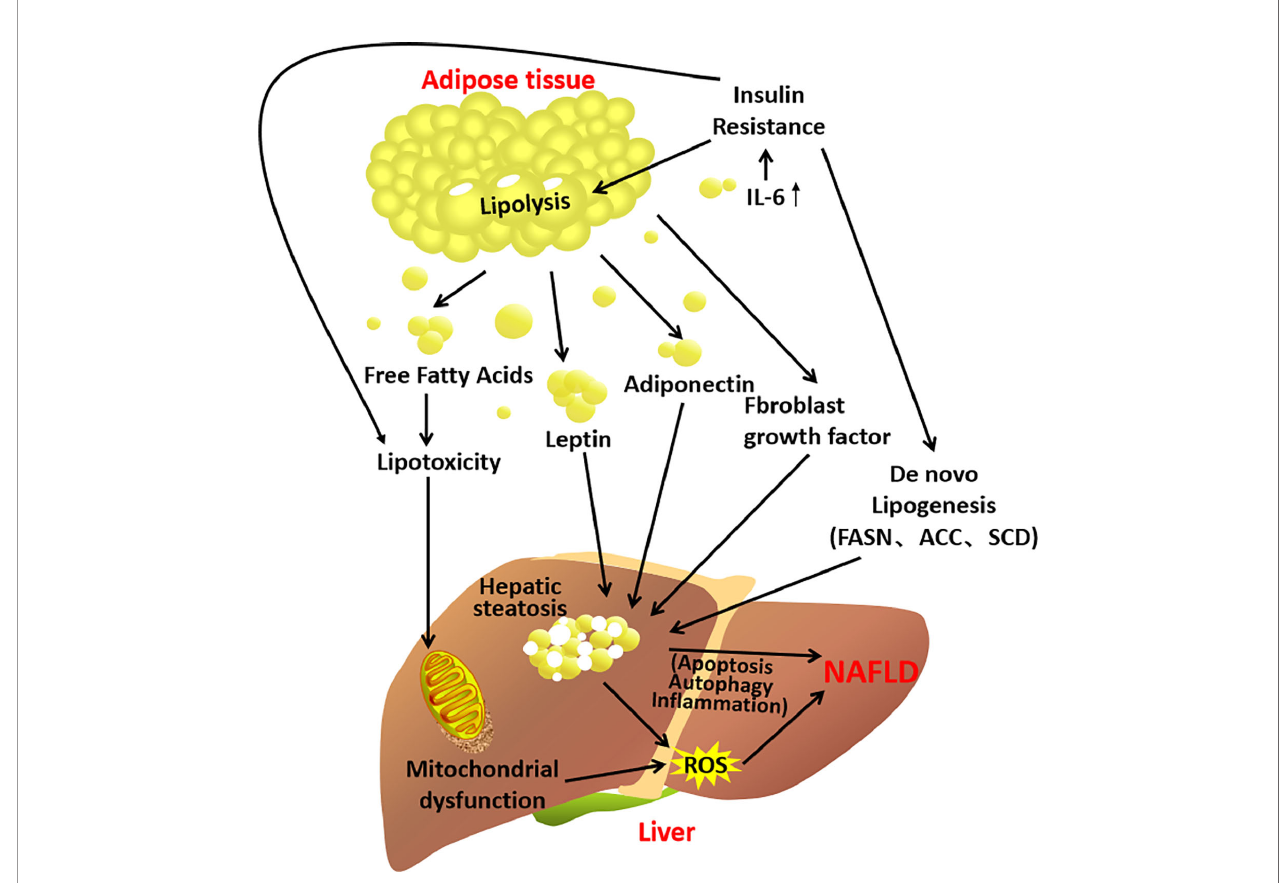
FIGURE 3 | A schematic diagram demonstrating the contribution of the adipose tissue – liver axis in NAFLD